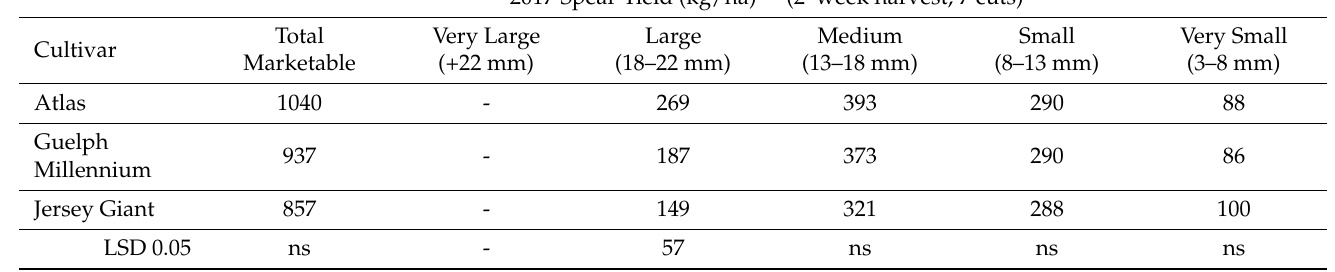
Table 3. Effect of asparagus ( Asparagus officinalis ) cultivars (Atlas, Guelph Millennium, Jersey Giant) on spear productivity (kg/ha) during early establishment years (2016–2018). No harvest occurred in 2016, and the harvest years of 2017 and 2018 were analyzed separately due to differences in harvest